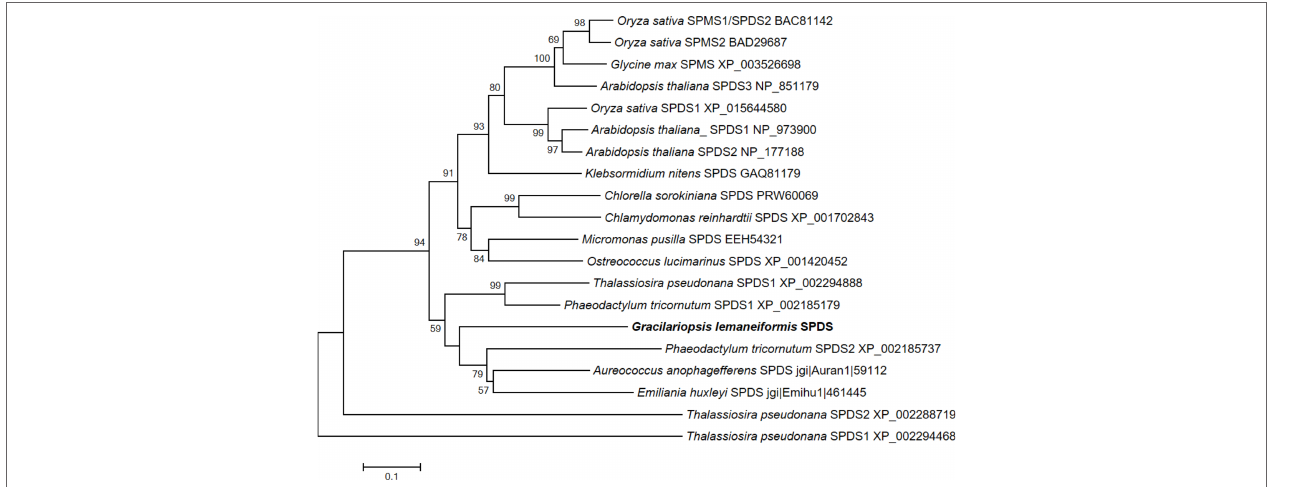
FIGURE 1 | Phylogenetic tree analysis of GlSPDS with other algae and plant SPDSs. Phylogenetic tree was constructed by neighbor-joining method using MEGA6 program. Percentage bootstrap values of 1,000 replications are indicated at each node. Public database accession numbers of SPDS proteins are shown following the protein